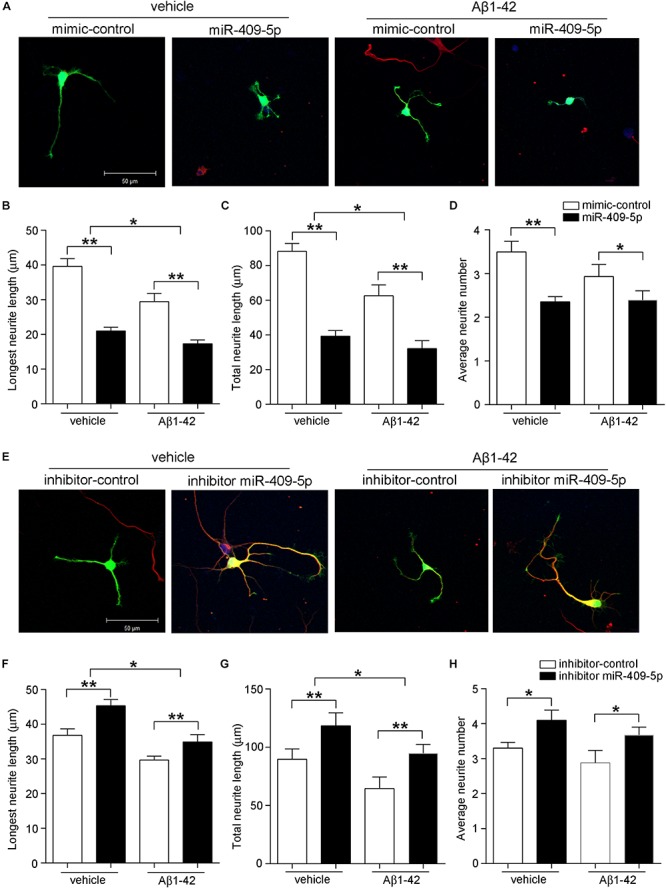
MiR-409-5p aggravated the insult of Aβ1–42 on neurite growth and branching in primary cultured hippocampal neurons. Mouse primary hippocampal neurons were transfected with PEGFP-C2 (0.5 μg) and miR-409-5p mimic (100 nM) (A–D) or inhibitor (100 nM) (E–H) before culturing, followed by Aβ1–42 treatment (5 μM) or vehicle. After 3 days, cells were fixed and immunostained with anti-β-tubulin III antibody. The longest neurite length, total neurite length, and branch numbers were quantified by ImageJ software. The results were shown as the mean ± SD (∗p < 0.05,∗∗p < 0.01). The experiment was repeated independently for three times. Red, β-tubulin III; Green, GFP; Yellow, merged. Unpaired t-test was used to analyze differences.